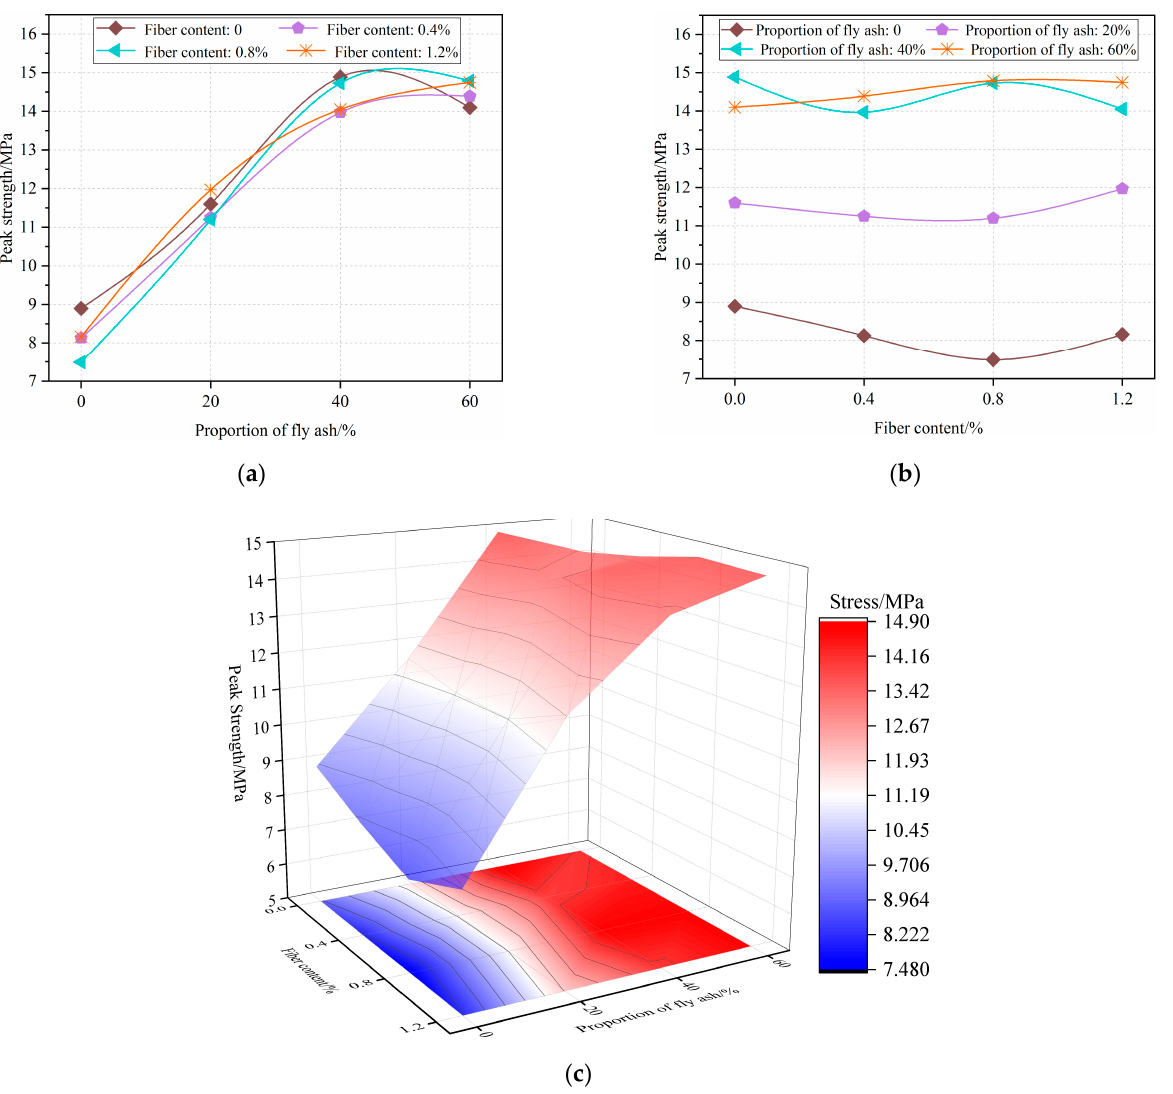
Figure 6. Impacts of the FA ratio ( a ) and SF content ( b ) on the peak strength, and the interactive effect of the FA proportion and SF dosage on the peak strength ( c ).